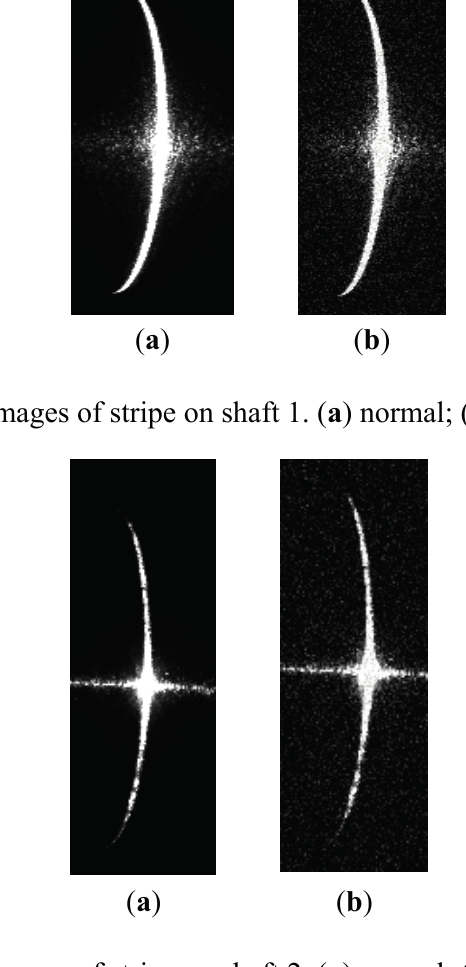
Figure 14. Images of stripe on shaft 2. ( a ) normal; ( b ) added noise. Table 9. Measurement results for shaft 1 (mm).